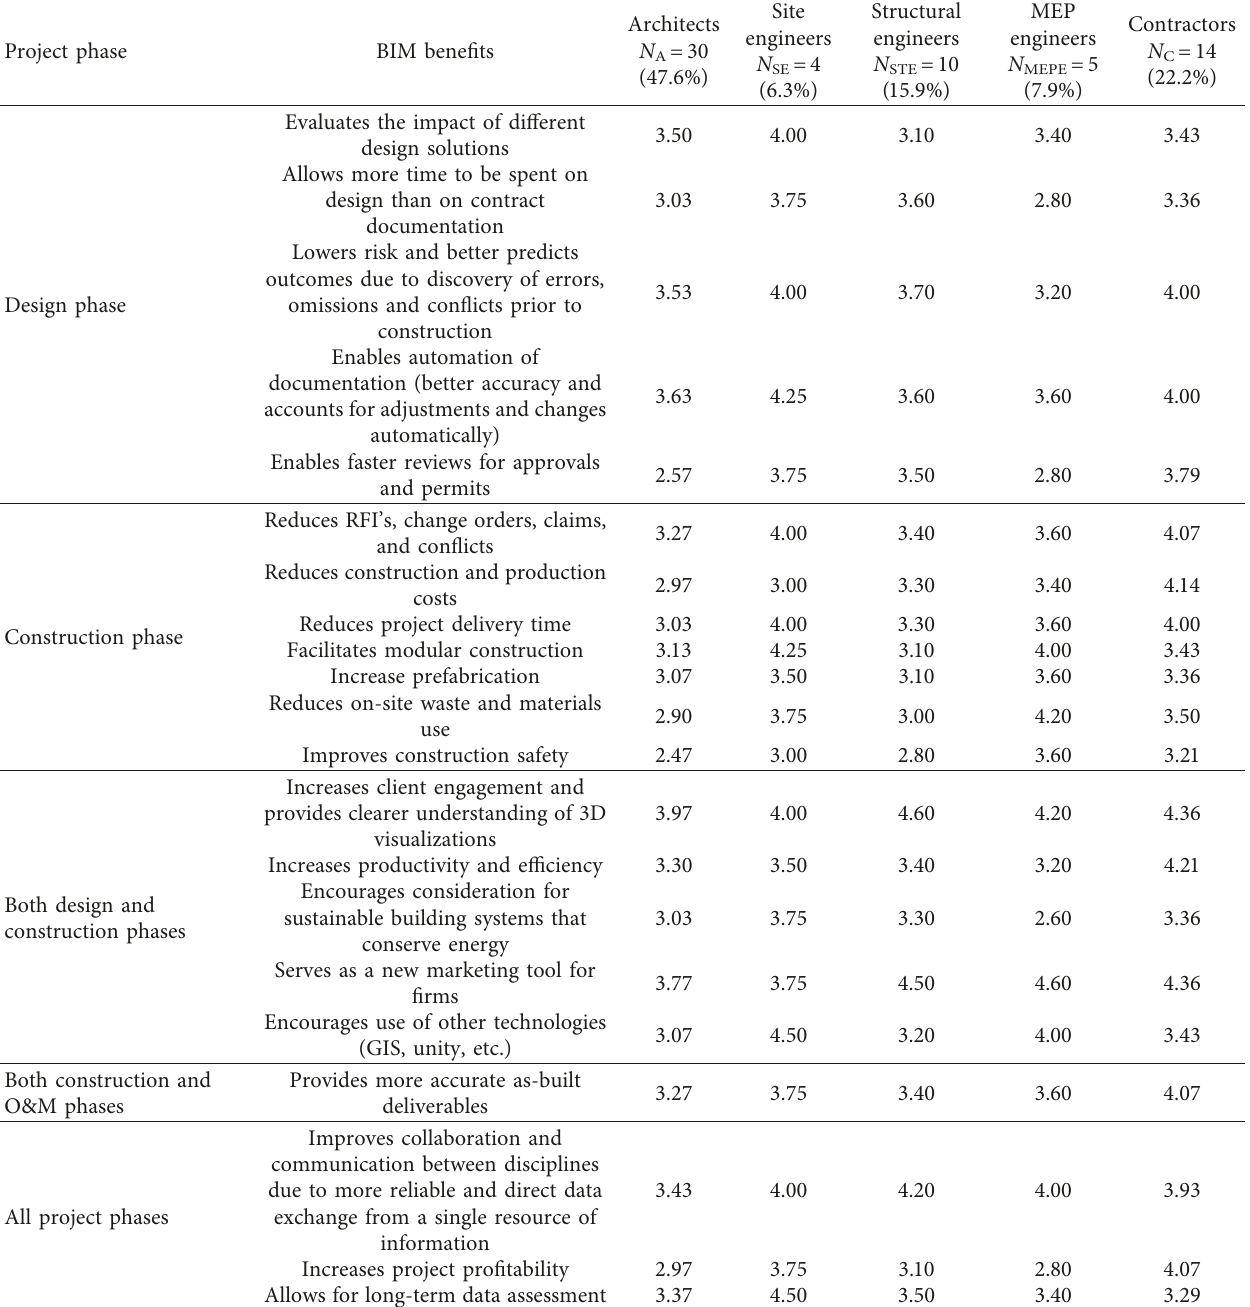
Table 10: Relationship between the role of the respondent and their level of agreement with perceived benefits of using BIM in educational facility projects (mean/average rating score) by the project